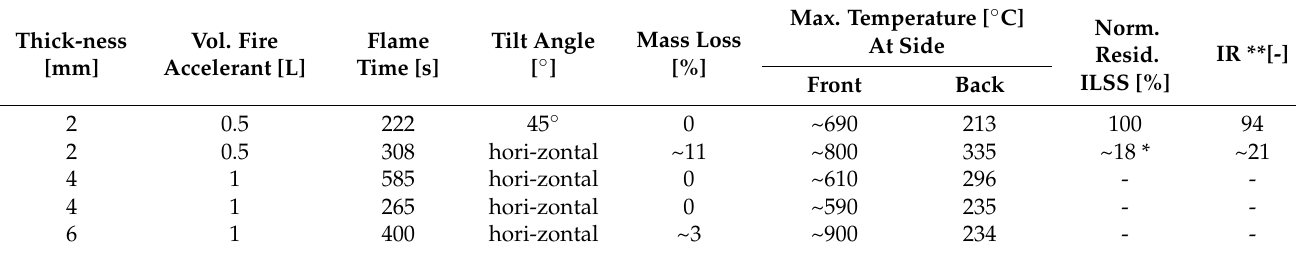
* Samples taken from the center of the panel fail in various plies. Value therefore does not represent realistic interlaminar shear strength (ILSS). ** Intensity ratio of IR bands at 1510 cm − 1 and 1780 cm − 1 (I